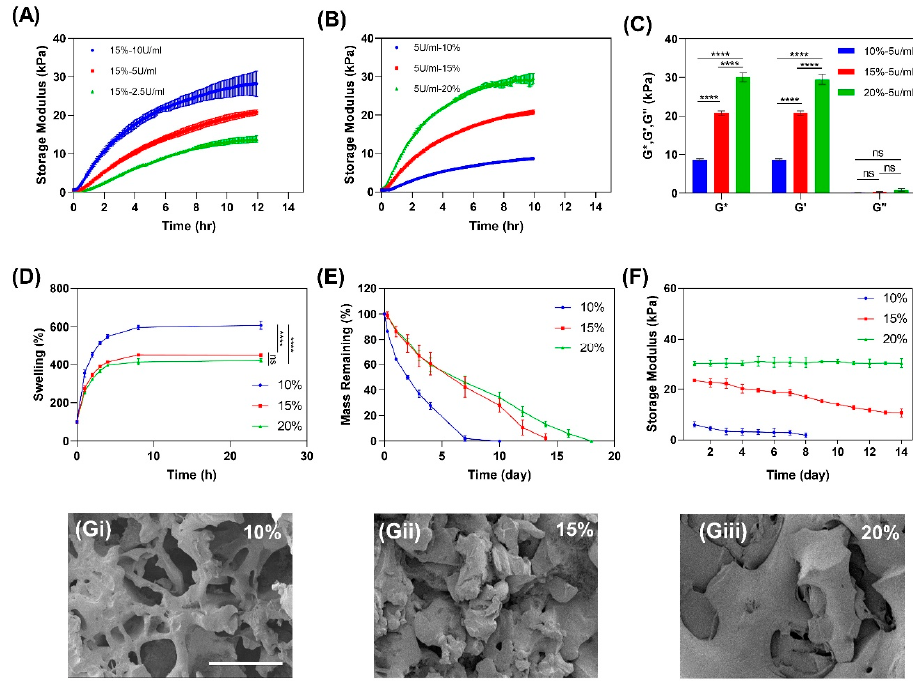
Figure 3. ( A ) Storage moduli of 15% gelatin crosslinking with 2, 5, and 10 U / mL of TG (n = 3). ( B ) Storage moduli of 10%, 15%, and 20% gelatin with 5 U/mL of TG (n = 3). ( C ) G*, G ʹ , and G ʺ of 10%, 15%, and 20% gelatin (n = 3). ( D ) Swelling ratio (n = 3). ( E ) Mass remaining percentage during degradation in 2 U/mL collagenase (n=3). ( F ) Storage moduli of 10%, 15%, and 20% gelatin during cell culture (n = 3). ( G ) Scanning electron microscopy (SEM) images of gelatin with 10% ( i ), 15% ( ii ), and 20% ( iii ) concentrations; scale bar is 200 µm. (Error bars indicate standard deviation. ns and **** indicate nonsignificant and p < 0.001, respectively.)